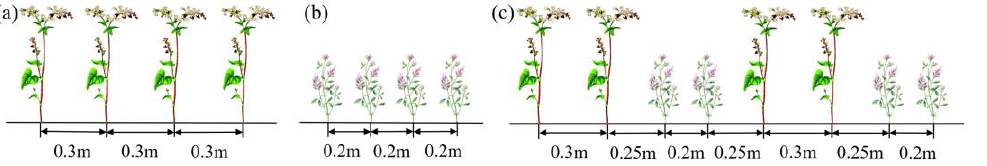
Figure 3. Diagrammatic representation of buckwheat-alfalfa cropping patterns; ( a ) sole buckwheat; ( b ) sole alfalfa; ( c ) buckwheat-alfalfa intercropping.